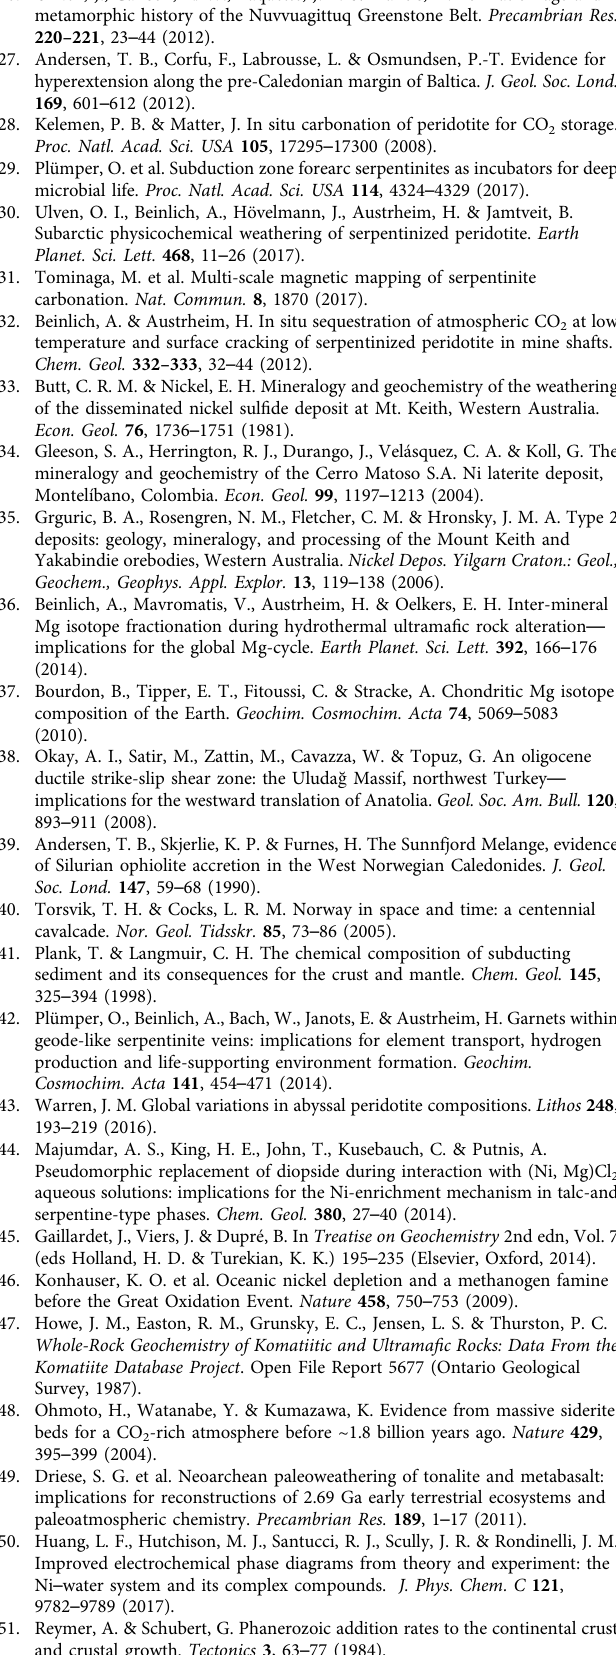
metavanadate, and hydro fl uoric acid in an open system. Ferrous ammonium sulphate is added after digestion and potassium dichromate is the titrating agent. Weight fractions of dry CO 2 sample gas are measured by infrared absorption after decomposing 0.2g of sample material in a resistance furnace in a pure nitrogen environment at 1000°C, using an ELTRA CW – 800